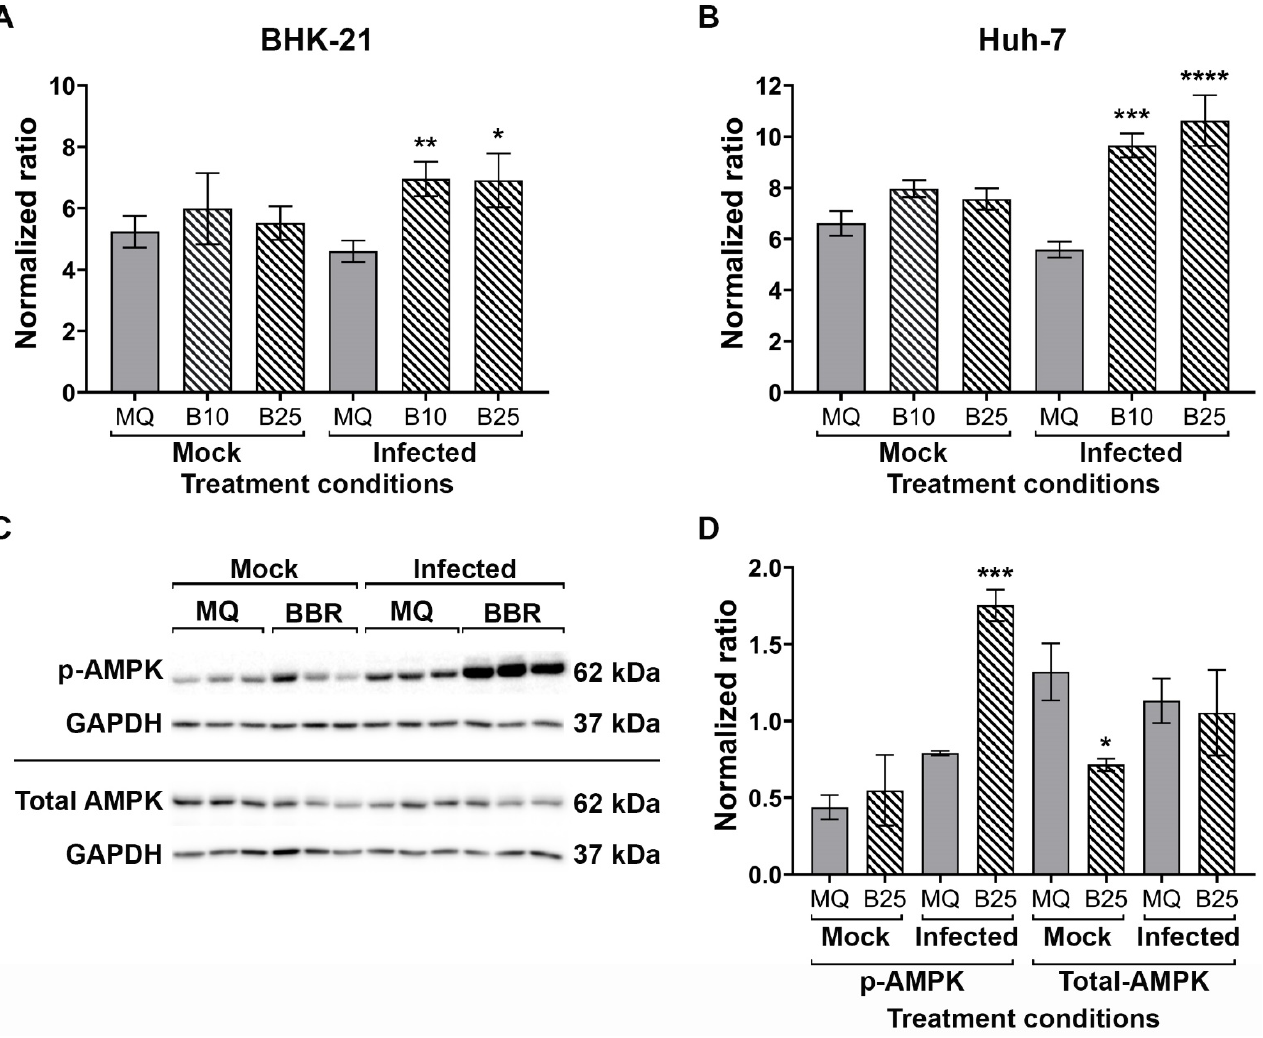
Figure 5. Effect of BBR on lipid droplets and AMPK. ( A ) BHK-21 and ( B ) Huh-7 cells were mock or DENV 2 infected followed by treatment with BBR or vehicle control (MQ). After 24 h cells were fixed and stained with ORO which was then eluted, and the absorbance was measured. Intensity levels were normalized to total protein. ( C ) BHK-21 cells were mock or DENV 2 infected followed by treatment with BBR or vehicle control (MQ). After 24 h cells were collected and proteins prepared and expression of p-AMPK, total AMPK and GAPDH were determined by western blot analysis. p- AMPK and total AMPK were detected on separate filters. ( D ) Band intensities were quantitated and normalized to GAPDH. Experiment was undertaken independently in triplicate. Error bars show ± S.E.M. * p ≤ 0.05, ** p ≤ 0.01 *** p ≤ 0.001, **** p ≤ 0.0001.